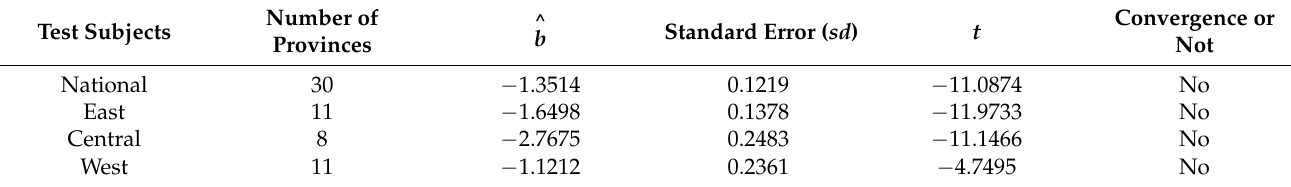
Table 3. Results of convergence tests for the national and regional club